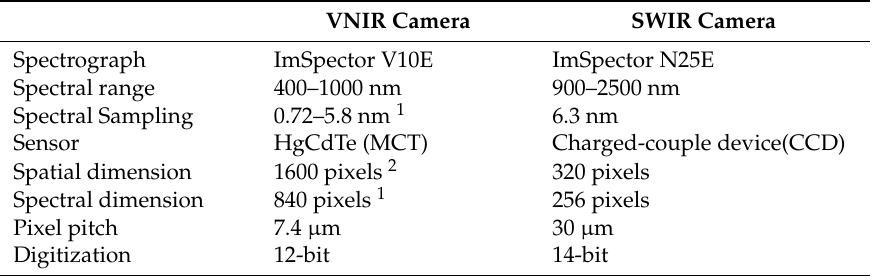
Table 1. Specifications of the VNIR and SWIR cameras from Spectral Imaging Ltd (Specim),